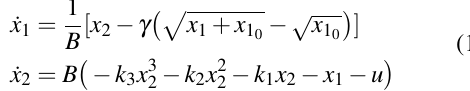
Figure 2: Compressor and throttle